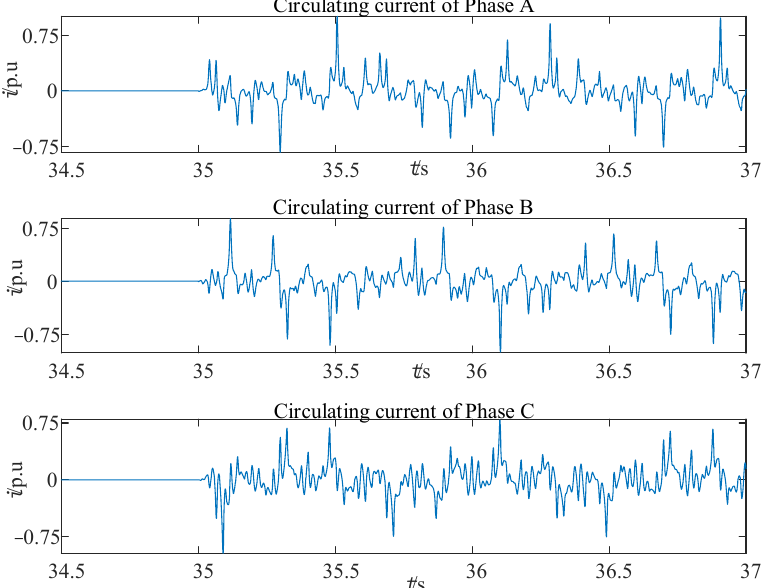
Figure 4. The transient circulating current of each stator phase (the inter-turn short circuit fault occurs at t = 35.0 and in rotor branch A2).